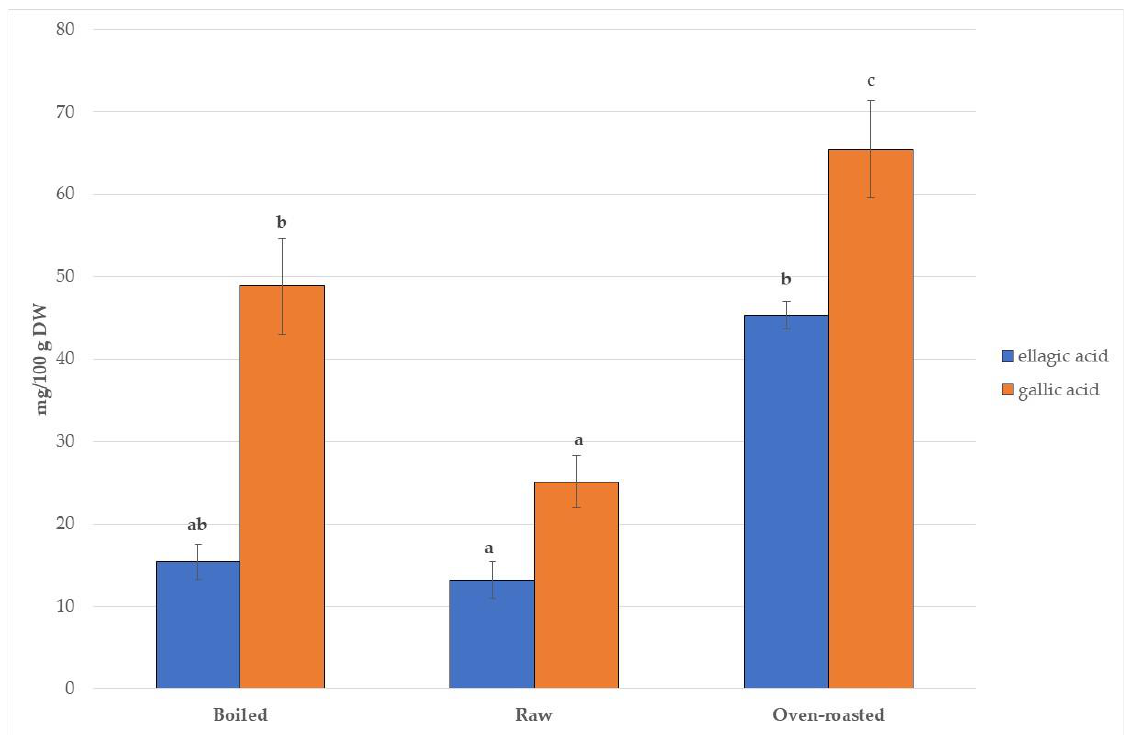
Figure 4. Profile of the benzoic acids in the analysed chestnuts in relation to each heat treatment. Different letters for the considered groups indicate significant statistical differences ( p < 0.05) among different “cooking method” groups for each compound.